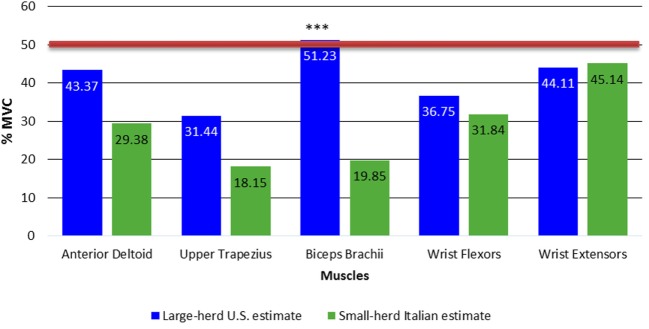
Simple main effects of dairy size × muscle interaction for 90th percentile APDF. Red line indicates limit values that muscle load should not exceed (31). ***p < 0.001. APDF, amplitude probability distribution function.